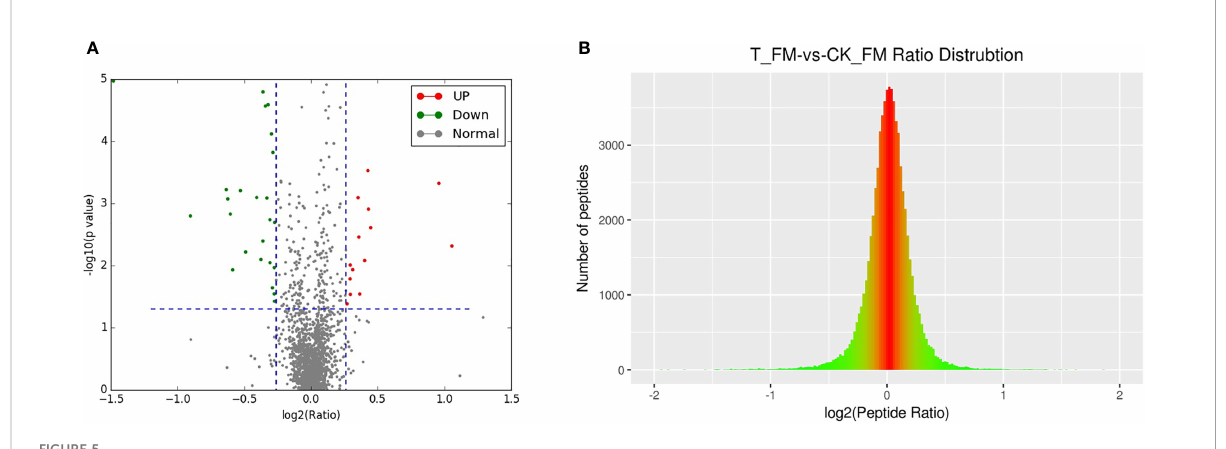
FIGURE 5 DEP distribution ratio of female adult